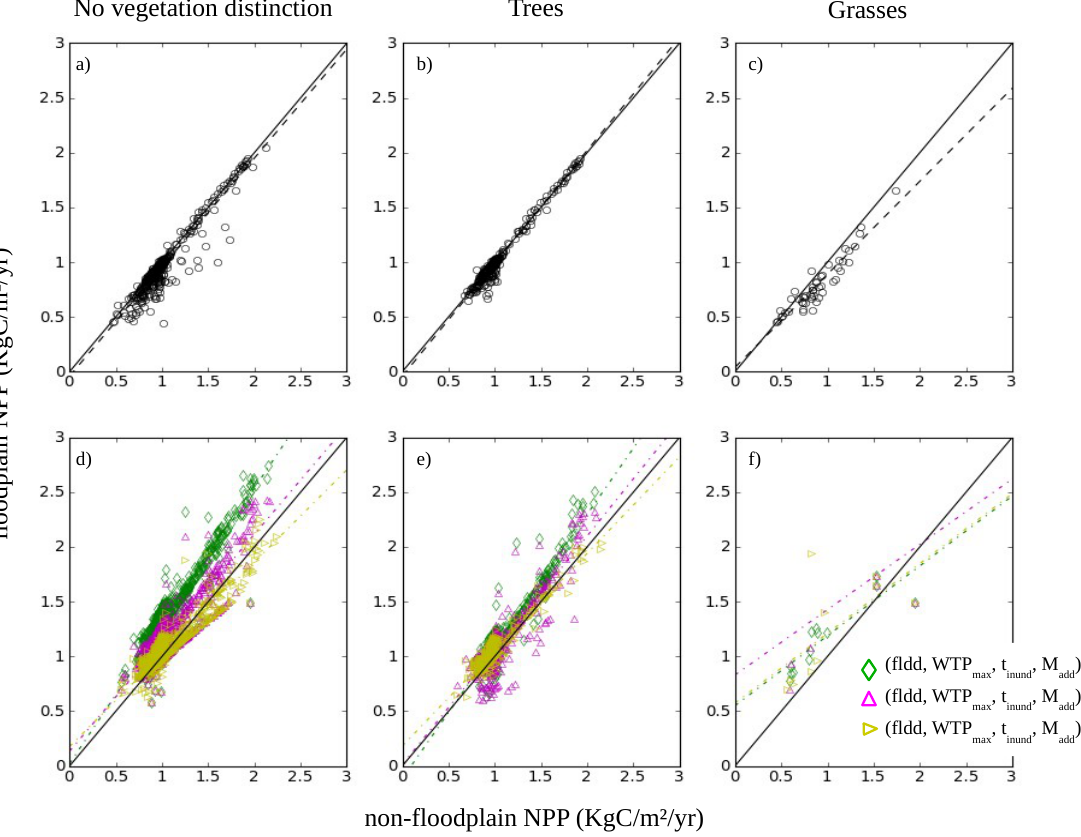
Fig. 4. Effect of flooded conditions on NPP for different vegetation types (left, middle and right columns for no vegetation distinction, trees and grasses, respectively) for both MODIS/GLC2000 (top panels) and LPX in case of application of a NPP (bottom panels). Each dot corresponds to a grid cell where the considered ecosystem occupies more than 5.1% of the grid cell for both floodplain and non-floodplain. As for Fig. 3, results of three LPX simulations varying through the used fldd and the tree parameterizations are given in the bottom panels. The reader should also report to Fig. A6 where the scatterplot corresponding to (e) is given separately for LPX simulations 1 and 2.